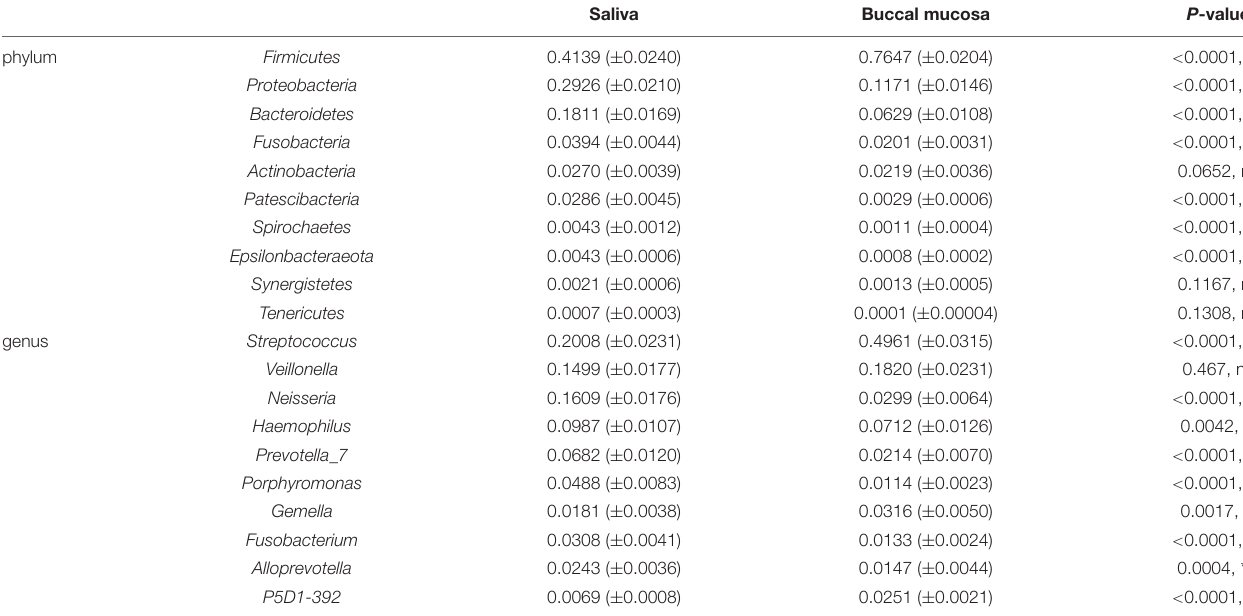
TABLE 1 | Relative abundance a of taxa differently distributed between saliva and buccal mucosa. Saliva Buccal mucosa P